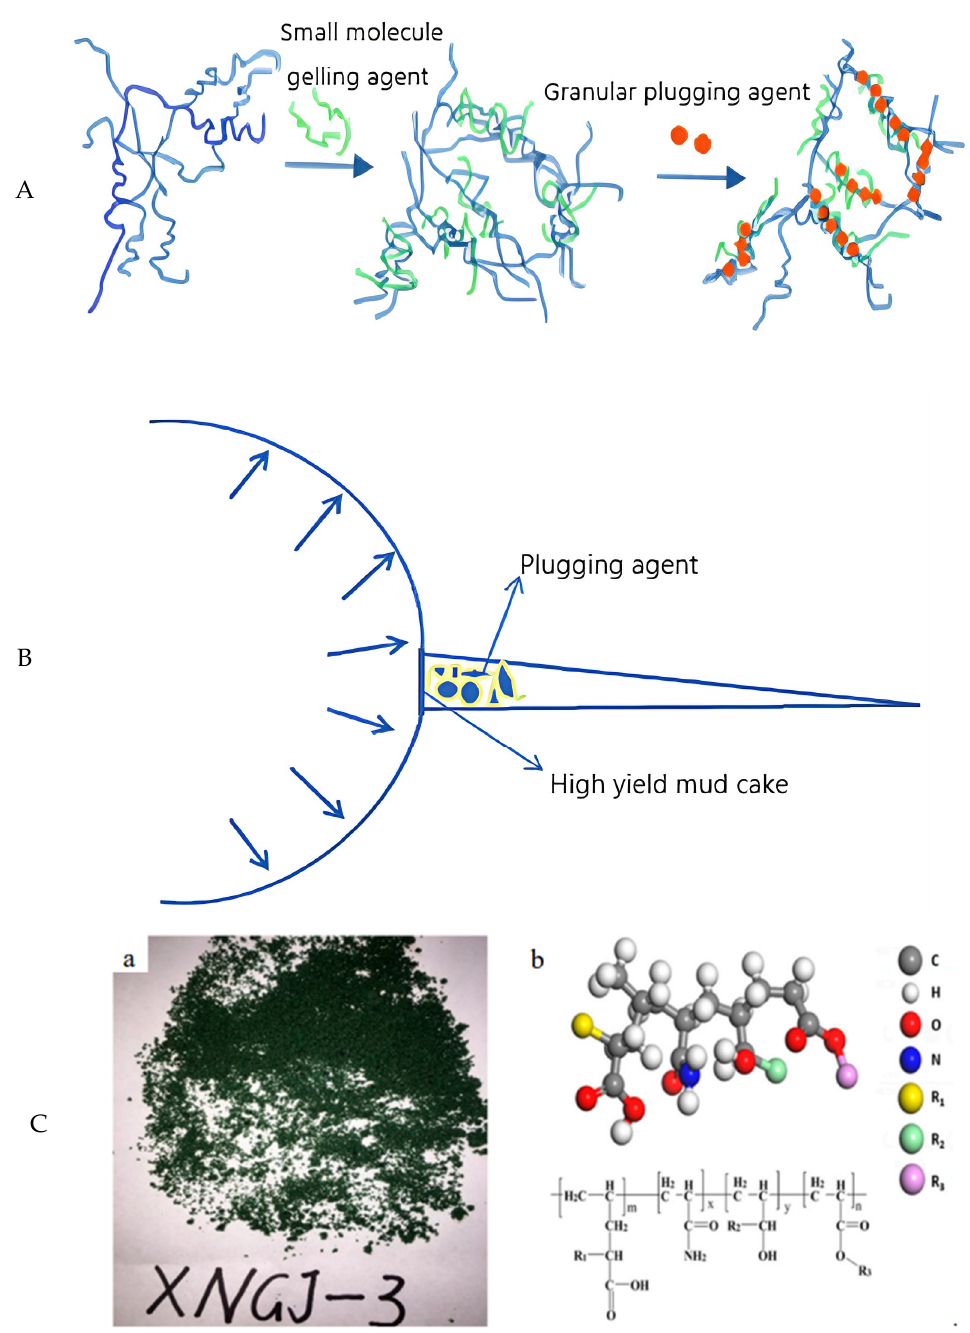
Figure 4. ( A ) “Multi ‐ far Cooperative Blocking” schematic diagram [82]. ( B ) Principle of improving crack compressibility [85]. ( C ) ( a ): Physical diagram. ( b ): molecular structure formula